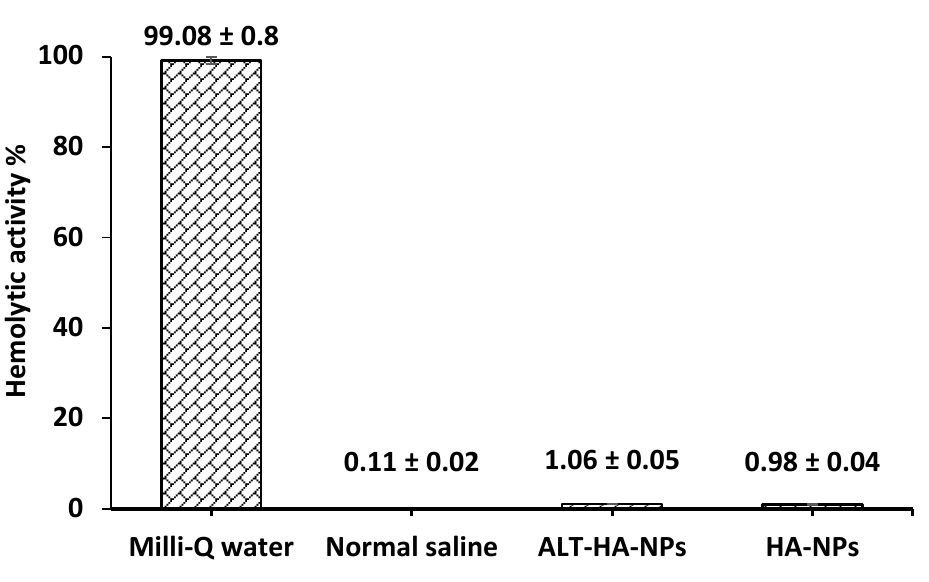
Figure 3. Hematolytic activity % for Milli-Q water, normal saline, ALT-HA-NPs, and HA-NPs (mean ± SD, n = 3, p <0.05).